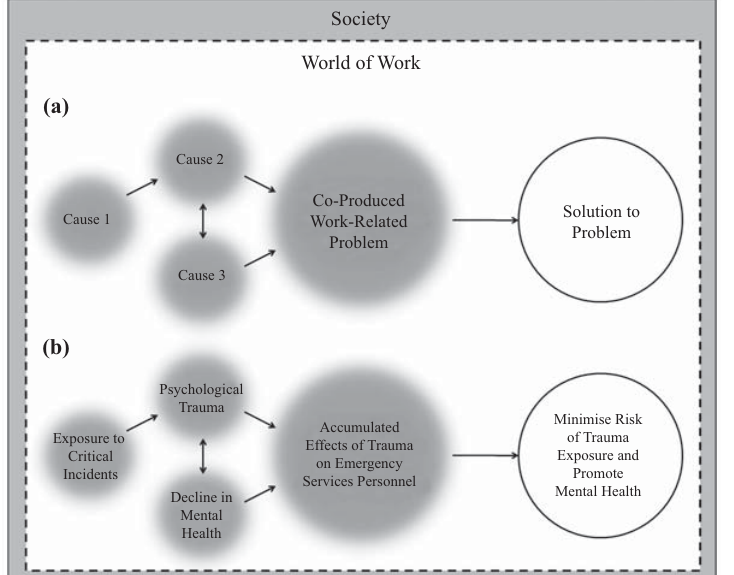
Figure 3. Conceptual model (a) and example (b) of a